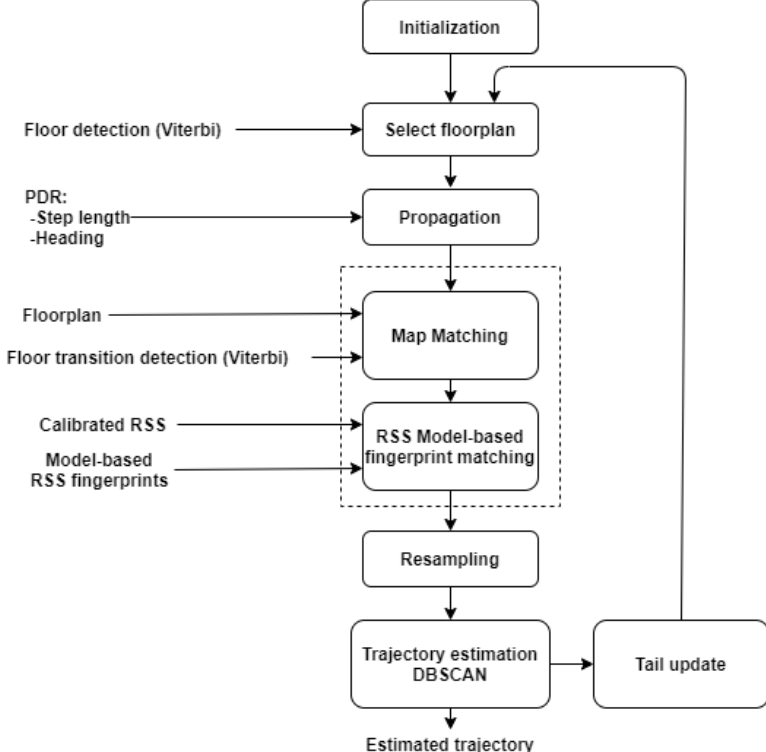
Figure 4. High-level flowgraph of the particle filter